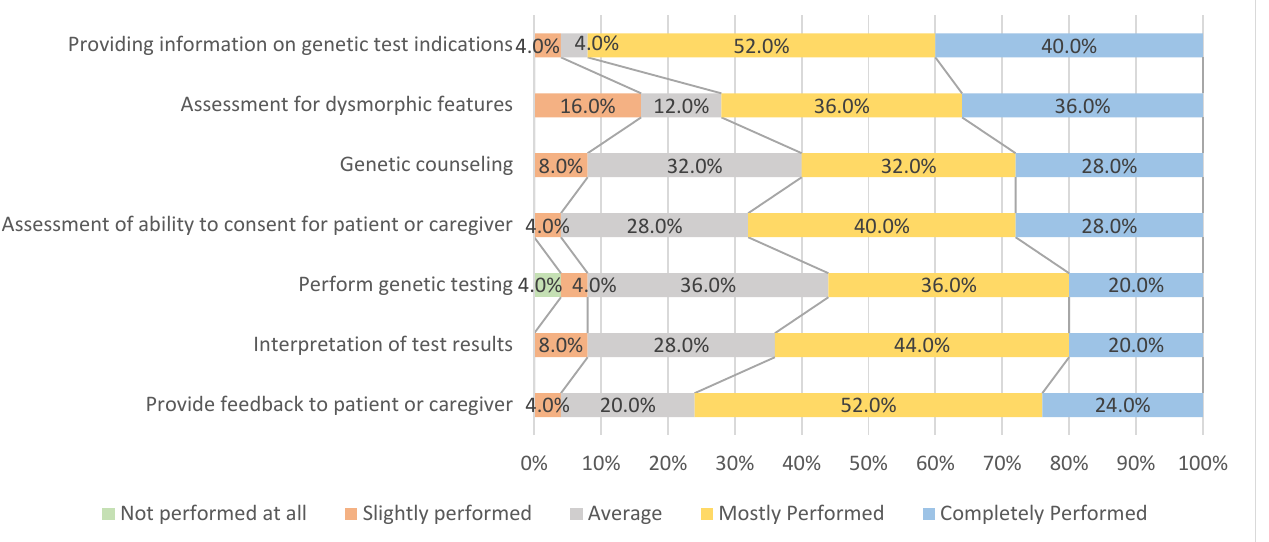
Figure 2. Implementation of each process when providing genetic testing service .